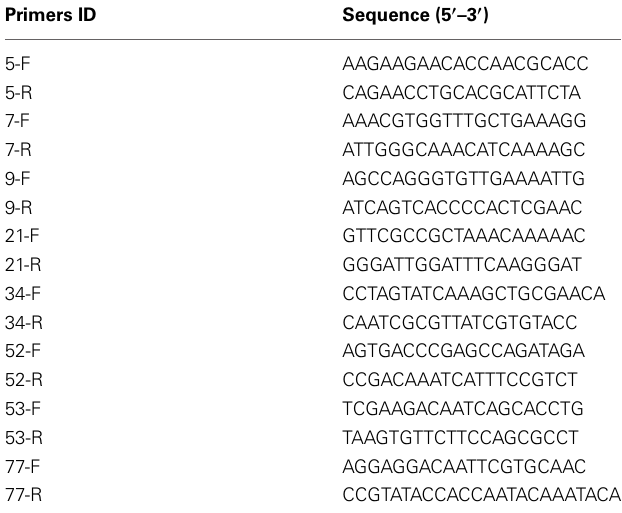
Table 1 | Sequences of primers used for microsatellite